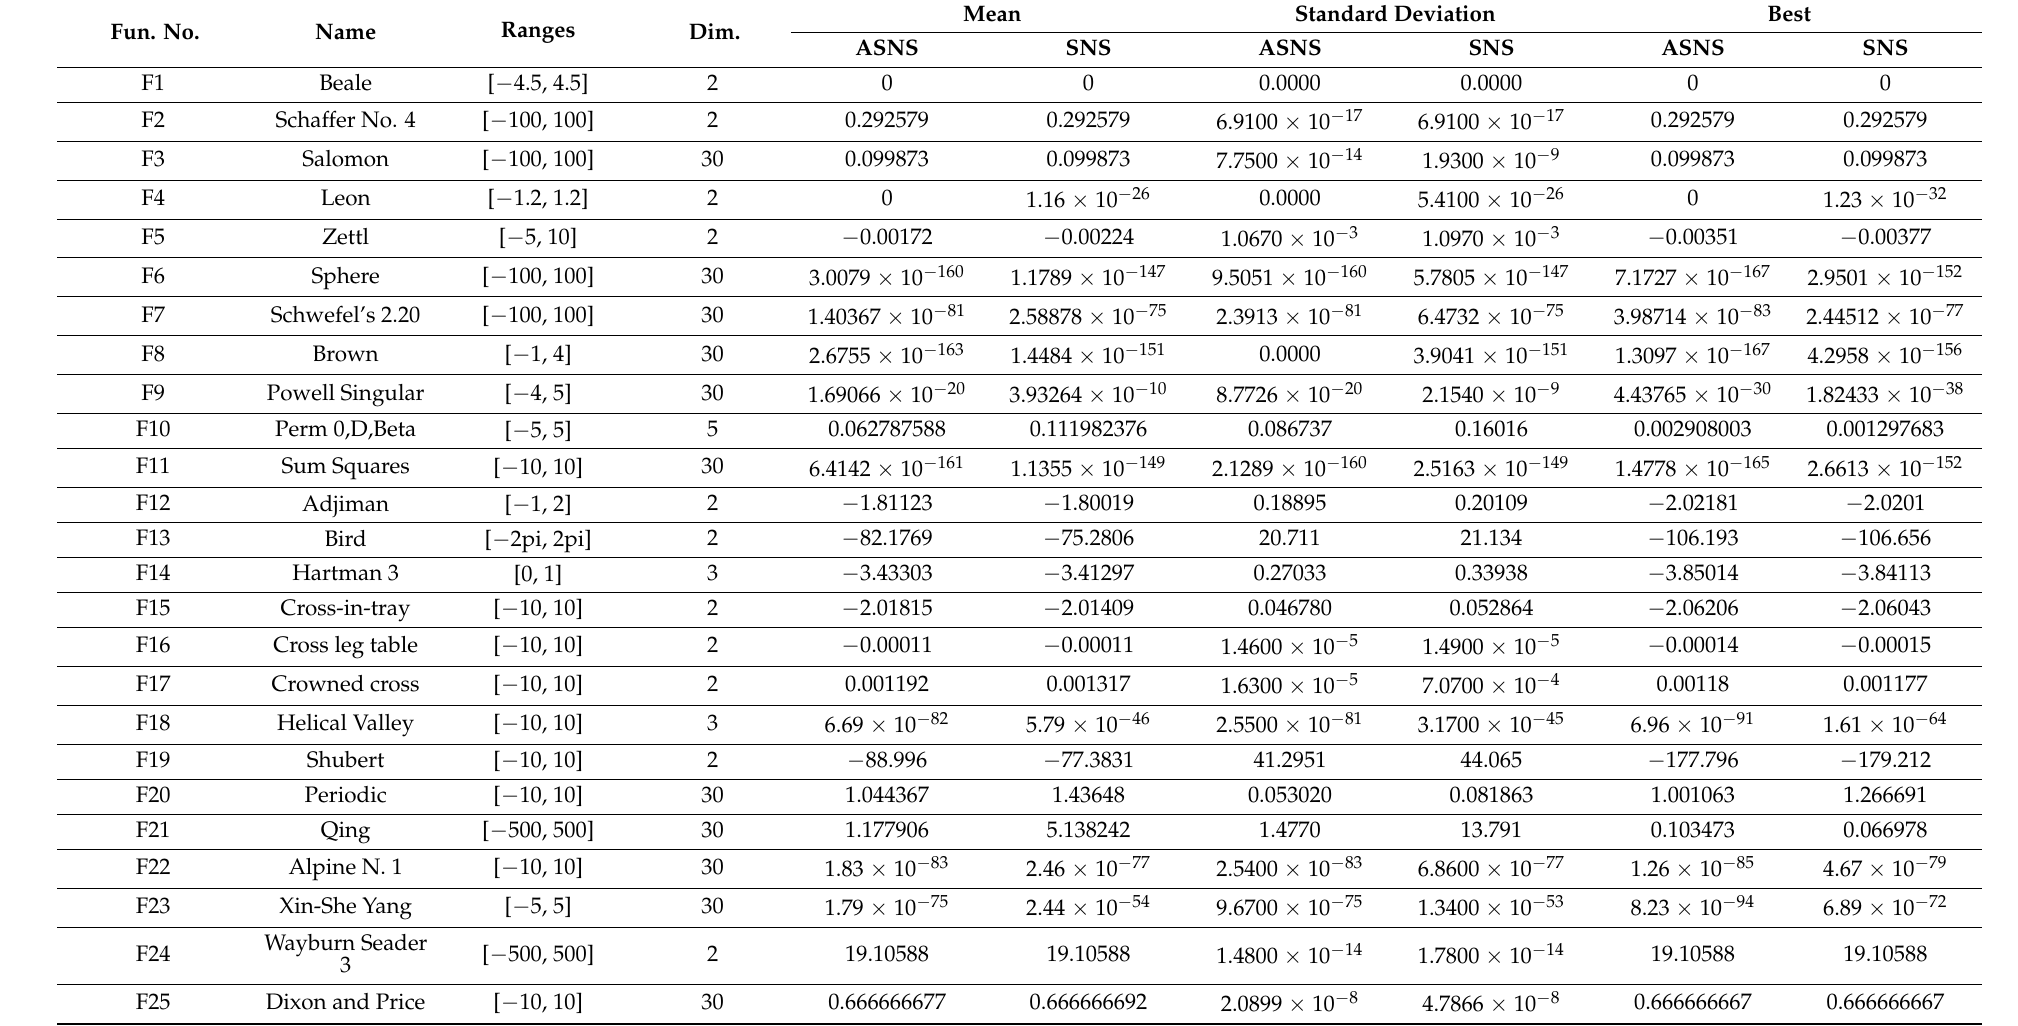
Table 17. Comparisons of the mean, best, and standard deviation using ASNS and SNS for benchmark functions. Fun.